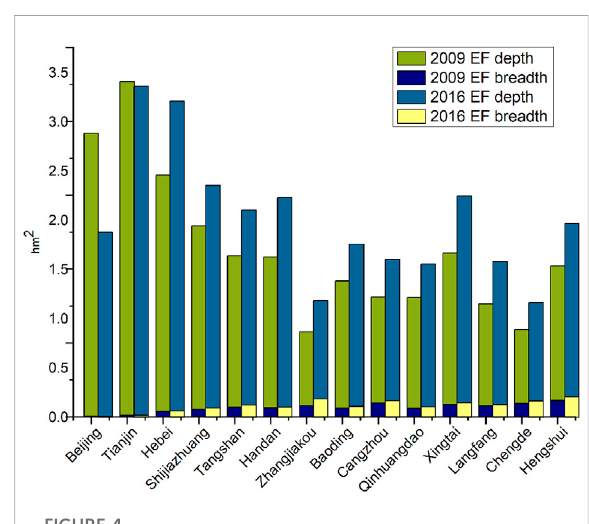
FIGURE 4 Comparison of ecological footprint depth in Beijing-Tianjin- Hebei region from 2009 to